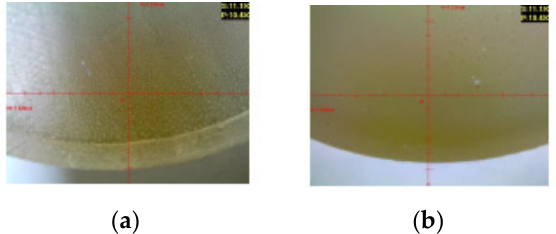
Figure 13. Samples aged in tap water for 3 months: ( a ) Epidian 53/Z-1; ( b ) Epidian 53/Z-1/CaCO 3 .